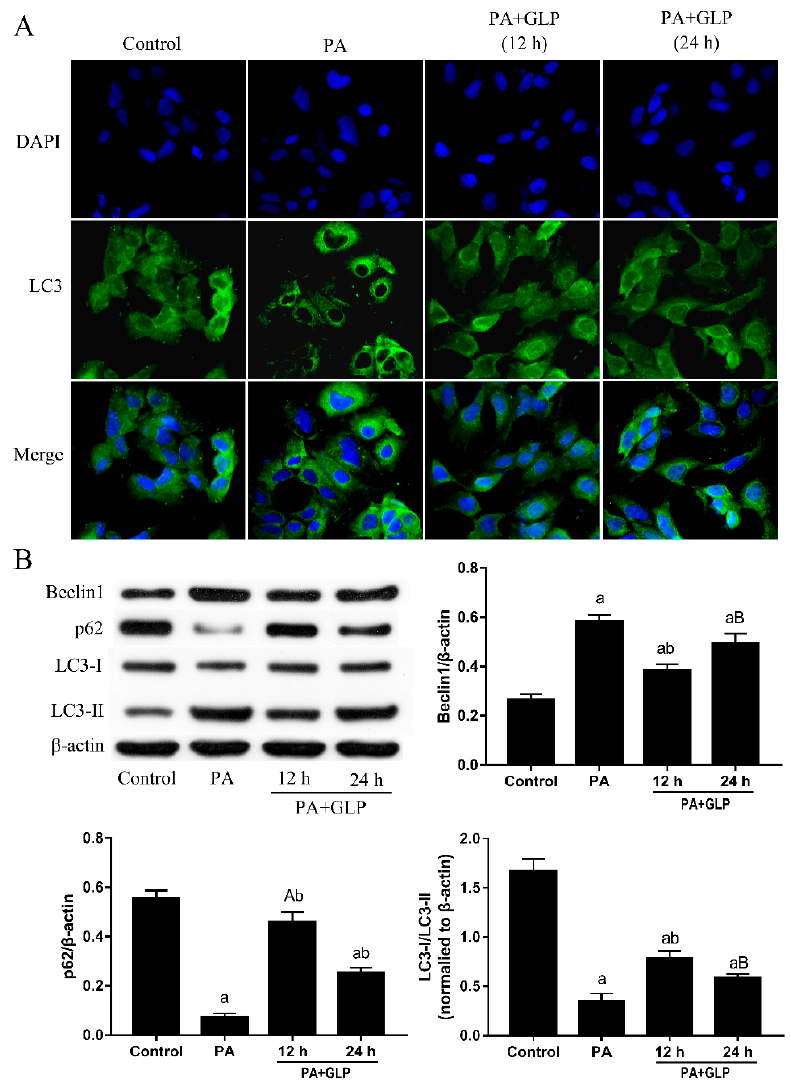
Figure 5. GLP ameliorated PA-induced autophagy in IPEC-J2 cells. Cells were treated with 600 µ M PA and GLP (0.4 and 0.8 mg/mL) for 24 h. ( A ) Representative LC3/DAPI images. Cells were stained for LC3 (green) and DAPI (blue), and the fluorescence was visualized in a fluorescence microscope. Original magnification 400 × . ( B ) The protein expressions of Beclin1, p62, LC3-I and LC3-II were subjected to Western blot analysis using indicating antibodies. The data were quantified and normalized to β -actin. Data shown are representative of three independent experiments ( n = 3). A < 0.05 and a < 0.01 vs. control, B < 0.05 and b < 0.01 vs. PA alone.